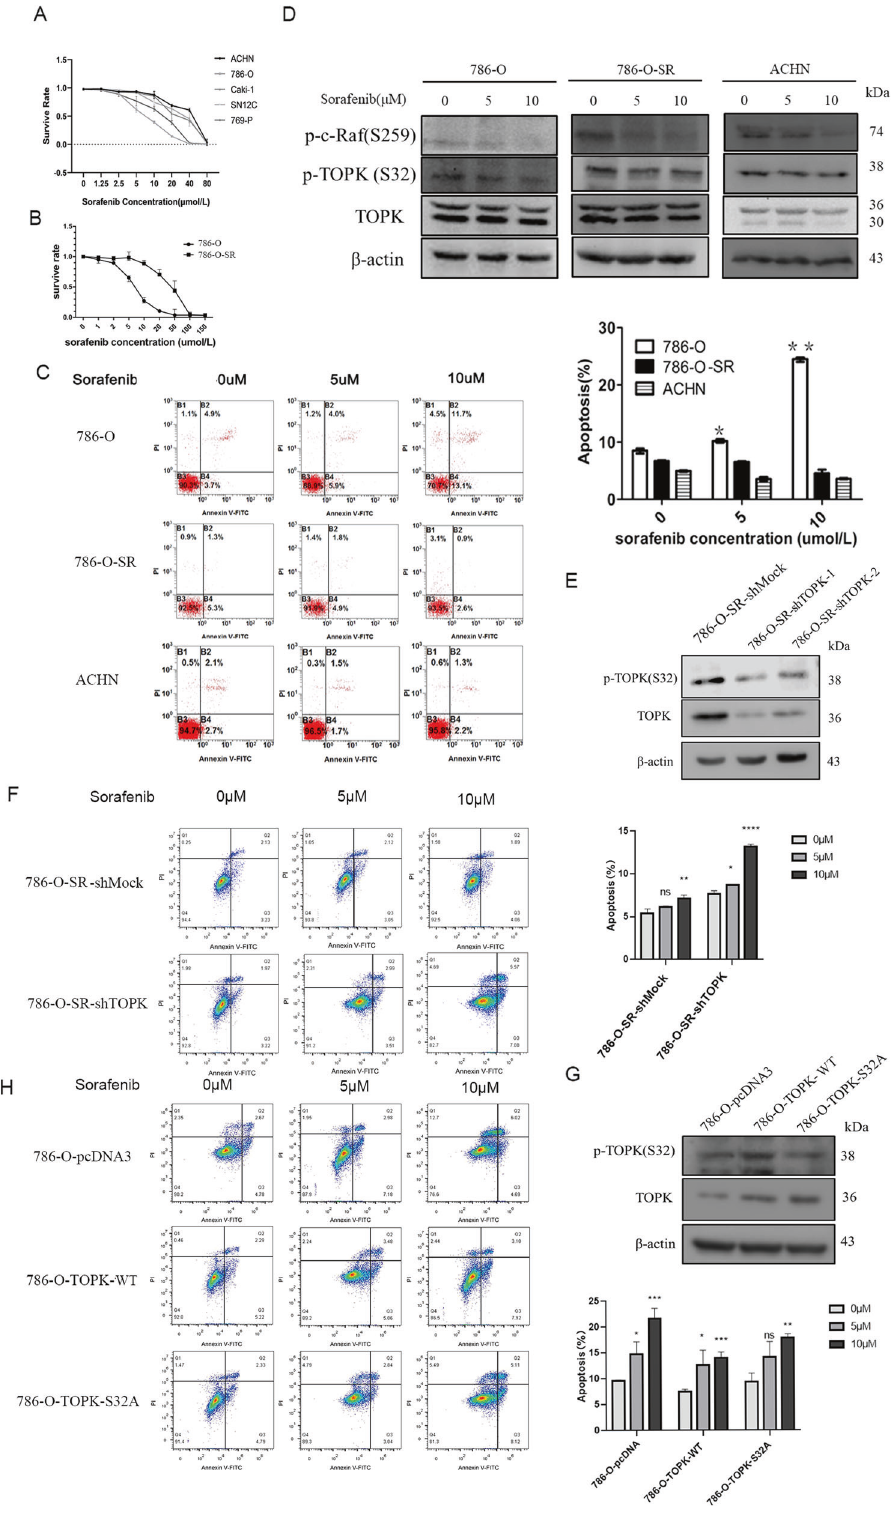
Fig. 4 The phosphorylation TOPK S32 was highly expressed in sorafenib resistance RCC cells. A The IC50 (half maximal inhibitory concentration) of fi ve RCC cell lines for sorafenib were dectected respectively. B The sorafenib sensitive cell line (786-O) was induced to resistance cell line (786-O-SR), the IC50 of the sorafenib in both 786-O and 786-O-SR was detected. C The apoptosis of 786-O, 786-O-SR and ACHN in different concentration of sorafenib was detected by fl ow cytometry, data were represented as means ± SD of triplicate experiments. *, means P < 0.05, **, means P < 0.01. D 786-O, 786-O-SR, ACHN were cultured with media contained with sorafenib of different concentration for 24 h before harvest. The expressions of p-TOPK (S32) and TOPK were determined by western-blot. E TOPK was knocked down in 786-O-SR with lentiviral infection. F The cells were treated with sorafenib of different concentration (0, 5,10 μ M), and fl ow cytometry was used to determine the cell apoptosis. G The plasmids of pcDNA3, pcDNA3-TOPK and pcDNA3-TOPK-S32A were stable transfected into 786-O cell lines respectively. H The cells were treated with different concentration of sorafenib (0, 5,10 μ M), and fl ow cytometry assay was used to determine the cell apoptosis. Cell Death and Disease (2022)